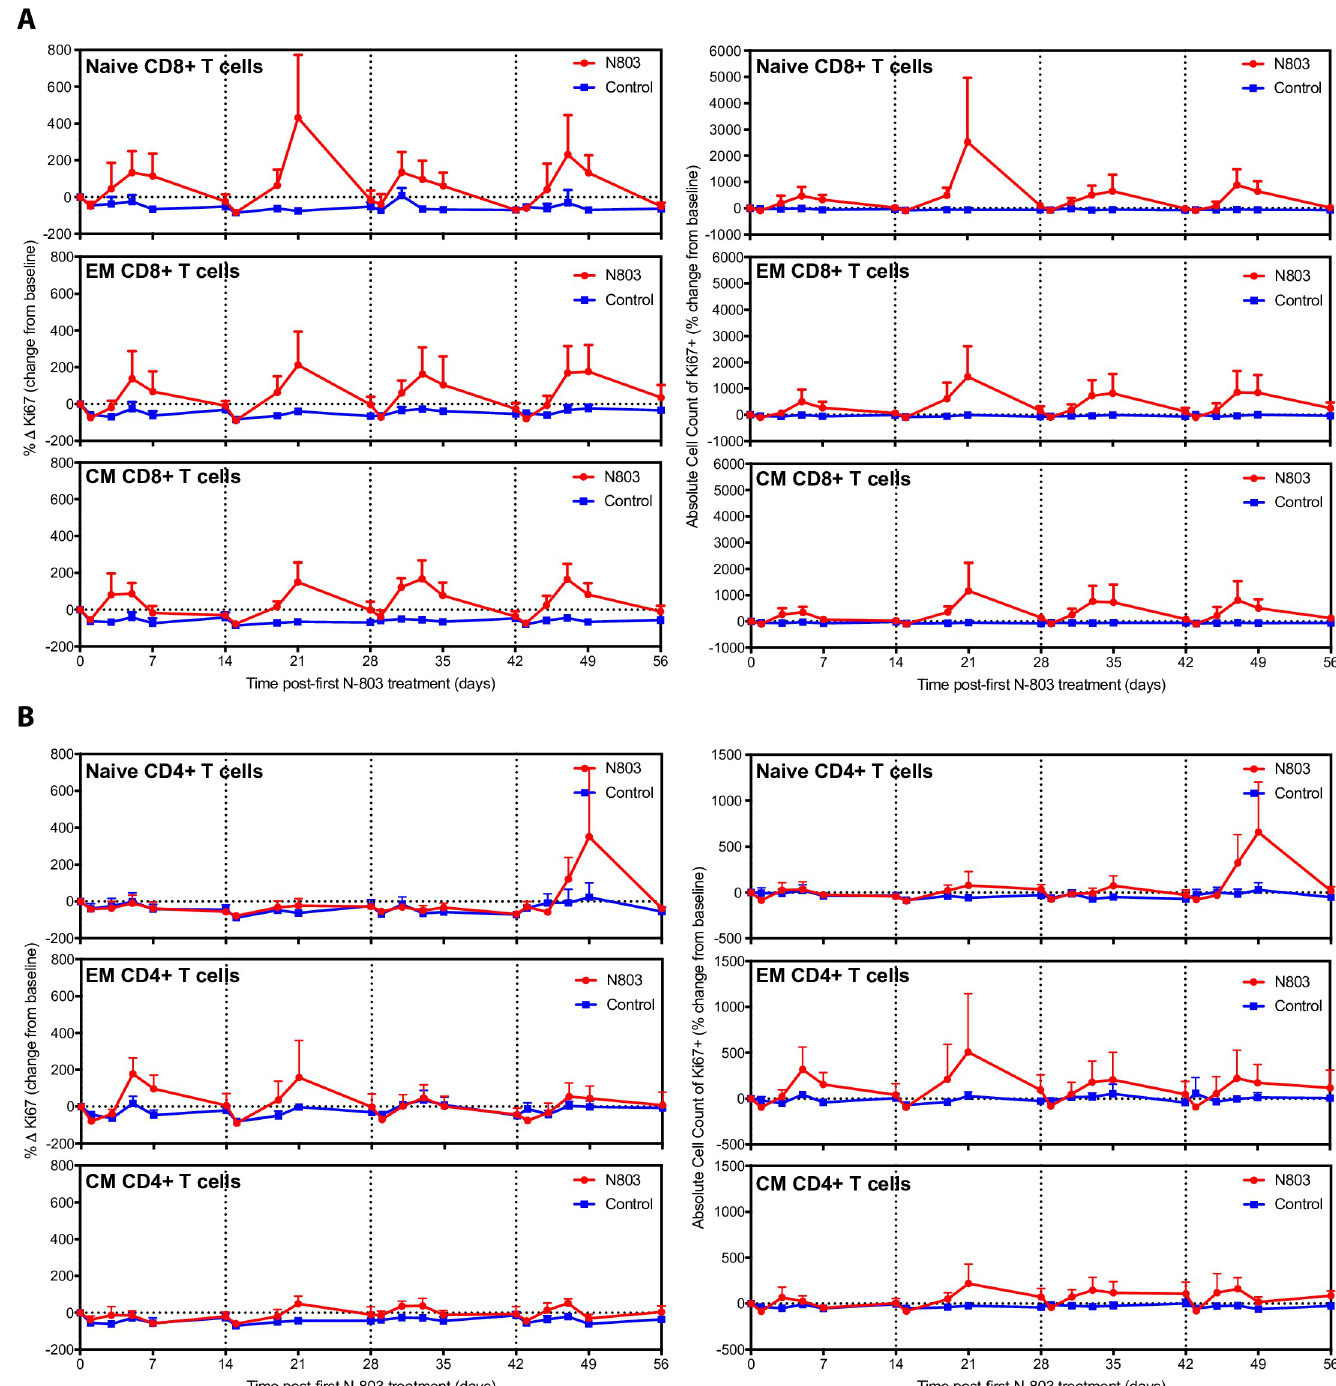
Fig 3. T cell memory analysis in blood during in vivo administration of N-803. (A) Induction of proliferation marker Ki67 on memory CD8+ T cells as percent of subset on the left, absolute cell counts on the right, both shown as a percent change from baseline. Absolute counts were calculated based on the percentage of the particular cell subset and the WBC count. (B) Induction of proliferation marker Ki67 on memory CD4+ T cells as percent of subset on the left, absolute cell counts on the right, both shown as a percent change from baseline. Absolute counts were calculated based on the percentage of the particular cell subset and the WBC count. Data shown are means ( ± SEM) of combined data from all animals within the designated group.